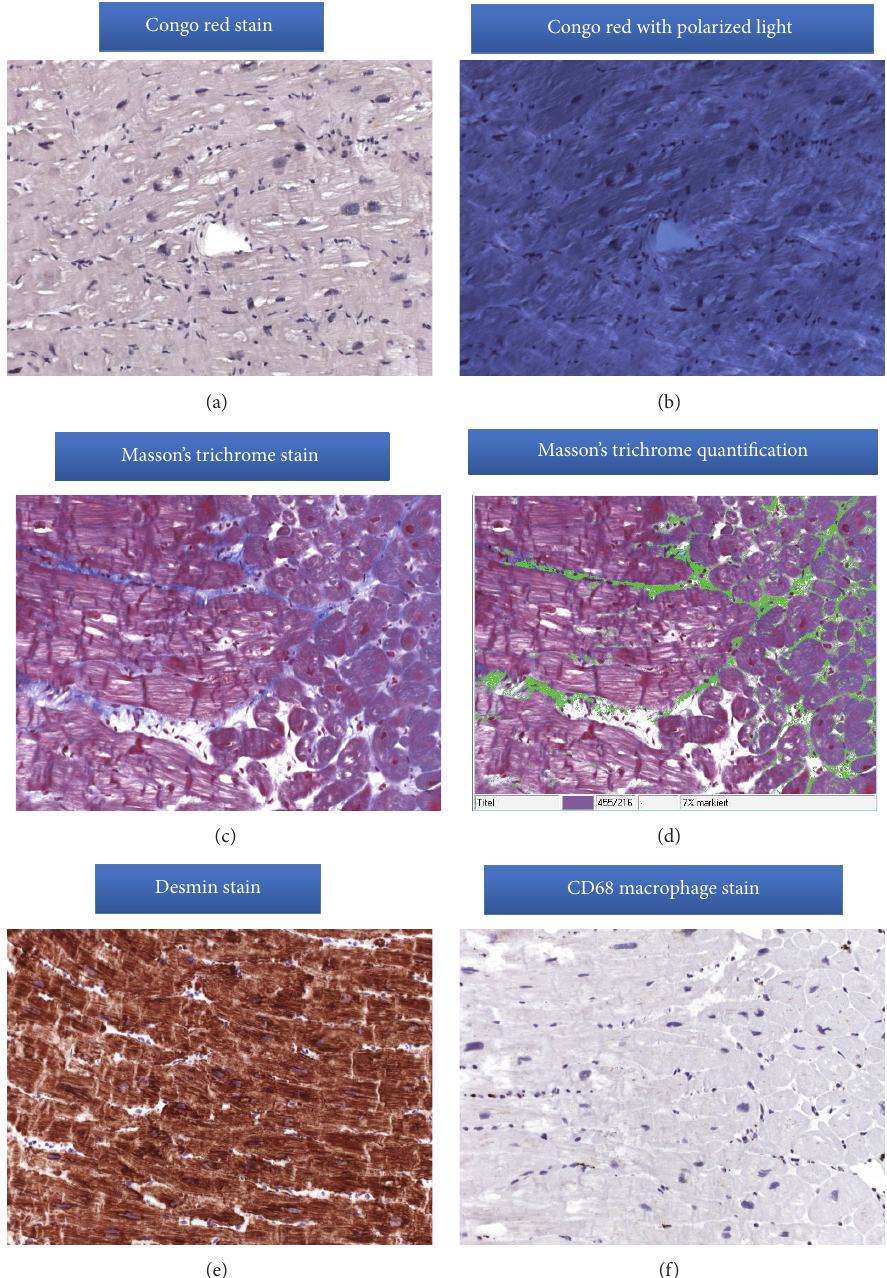
Figure 3: Congo red stain excluded the presence of amyloid in the heart ((a)-(b)), while Masson’s trichrome stain showed diffuse hypertrophy of myocytes and an interstitial fibrosis with the myocardium (blue areas (c), area of fibrosis of 7% by quantification analysis in (d)), indicating thepresenceofhypertensiveheartdisease.Inaddition,immunohistochemicalstainfordesminandCD68suggestedtheabsenceofmyocardial texture disorders and macrophage infiltration